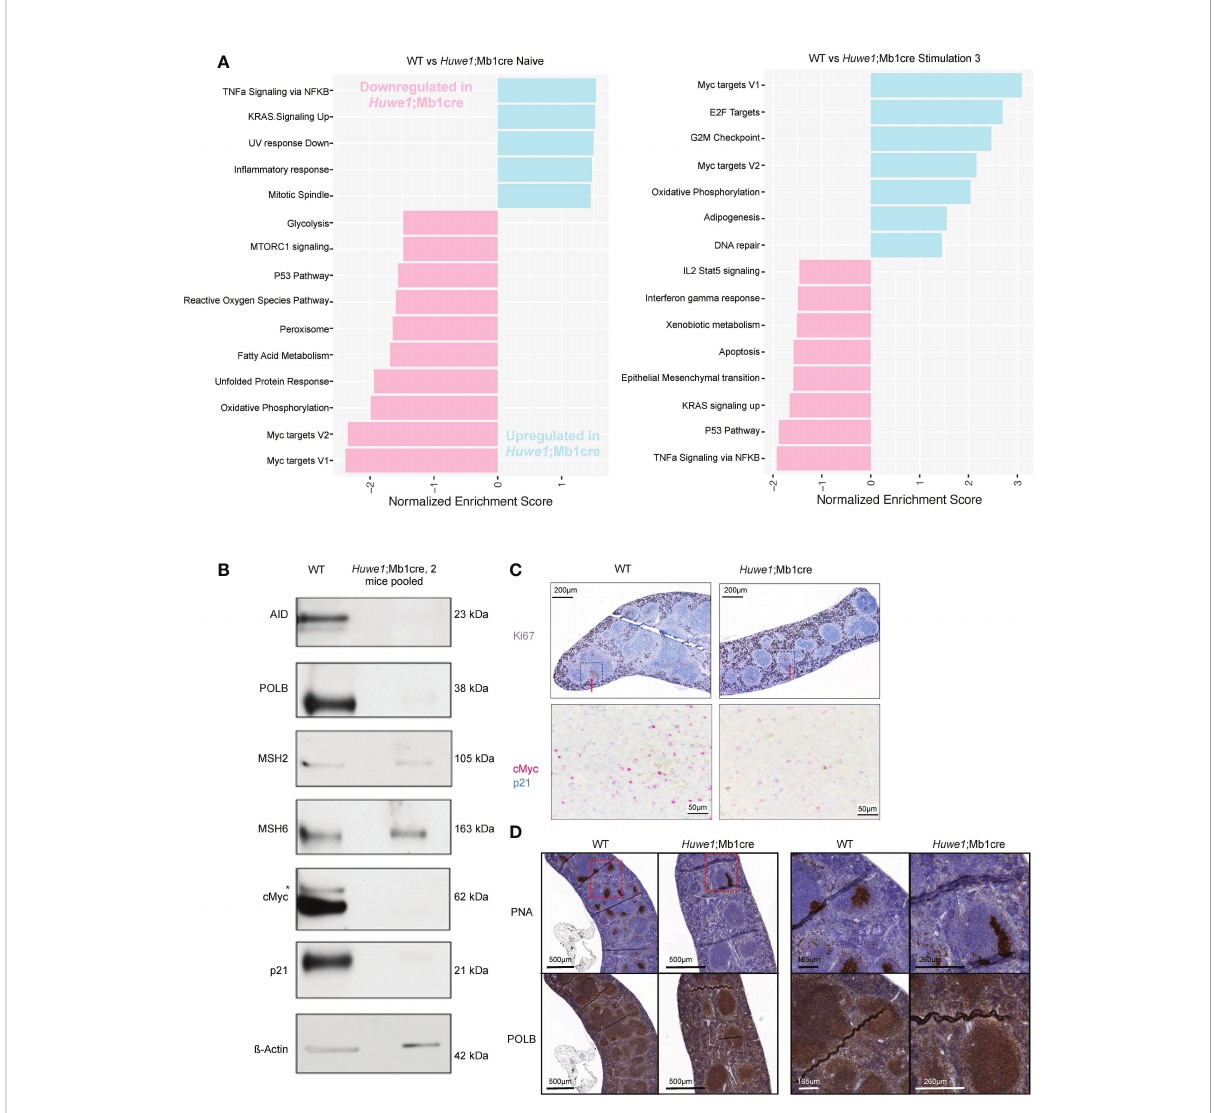
FIGURE 4 RNA-sequencing gene expression pro fi ling and protein expression analysis of HUWE1-de fi cient B cells. (A) Fast gene set enrichment analysis (FGSEA) of naive and stimulated B cells. Plotted is the normalized enrichment score (NES) of genes down and upregulated in Huwe1 ;Mb1cre (pink and blue, respectively.) For each condition, RNA-sequencing was performed on B cells from three independent mice. (B) Immunoblotting analysis of protein expression in activated splenic B cells stimulated with LPS+IL4+anti-IgD-dextran ( ‘ Stimulation type 3 ’ ). For each sample, 10 m g of total protein were used for protein separation. To obtain suf fi cient material, B cells from 2 Huwe1 ;Mb1cre mice were pooled. Aspeci fi c band in the cMyc immunoblot is indicated with an asterisk. b -actin is used as a loading control. (C) Immunohistochemistry (IHC) staining for Ki67 (visualized by 3,3 ’ -diaminobenzidine substrate, brown color) to identify proliferating cells and germinal centers in formalin- fi xed paraf fi n- embedded spleen sections from LCMV-infected wildtype (WT) and Huwe1 ;Mb1cre mice 14 days post-infection. The red arrows indicate the GC structures. The area surrounded by the box with the black dashed line corresponds to the area shown in the bottom panel of the fi gure studying by IHC the cells that express cMyc (pink) and p21 (blue) in splenic GCs from WT and Huwe1 ;Mb1cre unimmunized mice. (D) IHC staining for peanut agglutinin (PNA) to identify GCs, and DNA polymerase beta (POLB) in the spleens from LCMV-infected mice 14 days post-infection. Panels on the right are magni fi cations of the indicated boxes with the red dashed